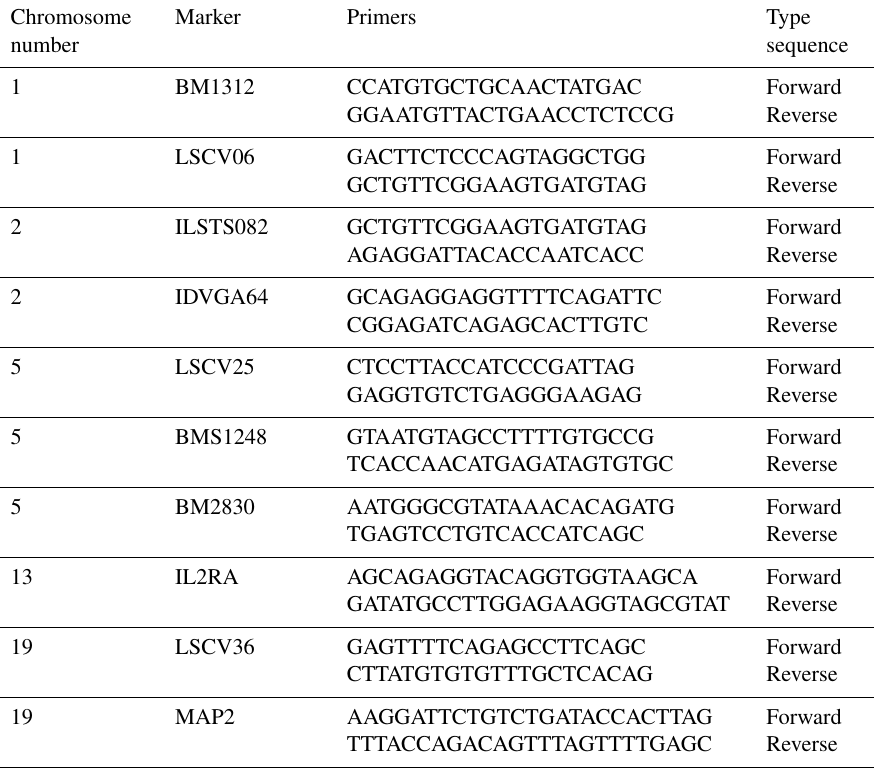
Table 1. Primer characteristics of amplified microsatellite loci. Chromosome